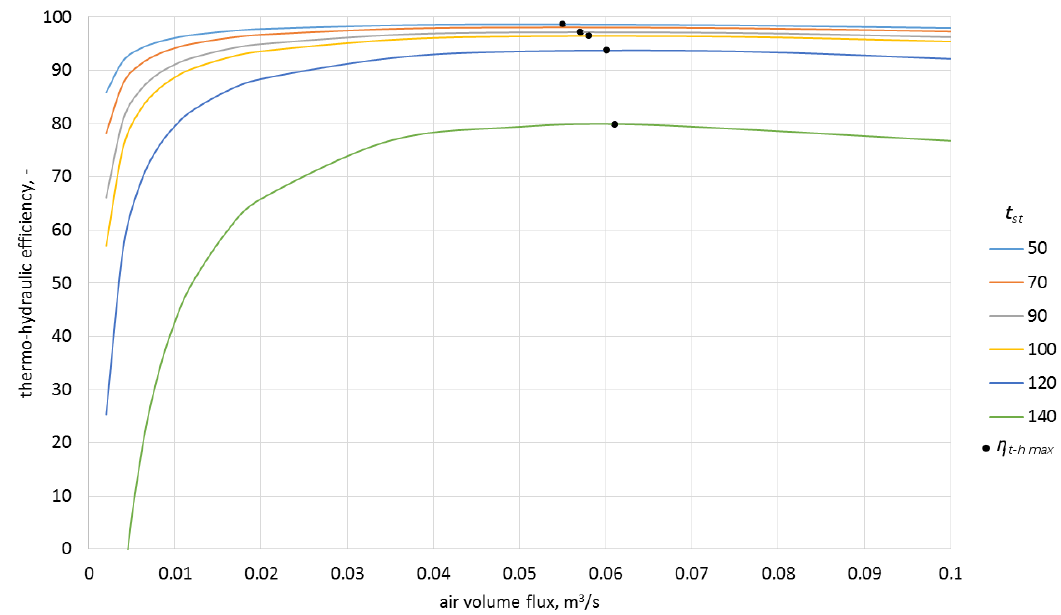
Figure 11. Thermo-hydraulic efficiency for the inlet temperature of 100 °C and various ceramic brick temperatures.